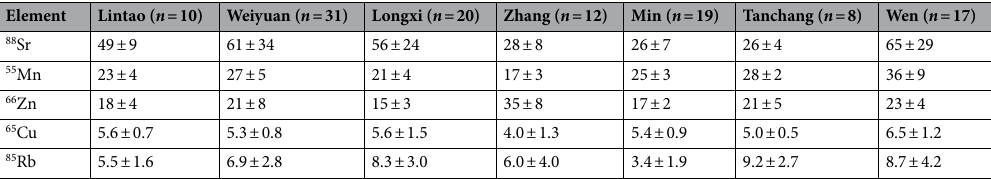
Table 2. Macro elements content of Codonopsis Radix samples according to their geographical origin (Content are expressed as μg/g of dry matter basis).